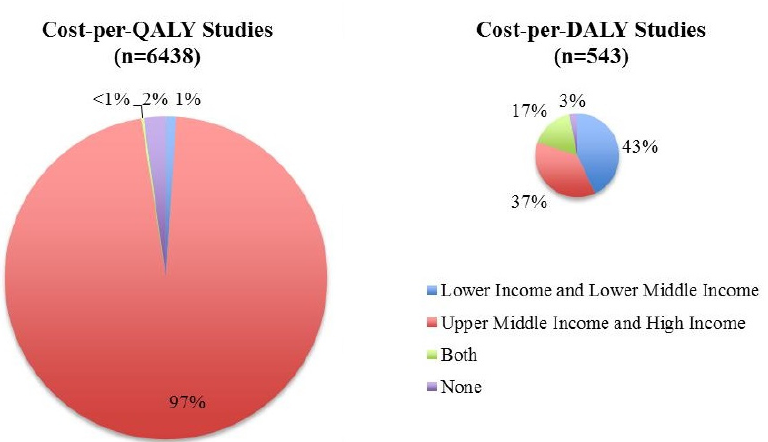
Figure 2. Cost-per-QALY vs. cost-per-DALY studies by world bank income level. The area of each pie chart is proportional to the number of studies catalogued in each registry.